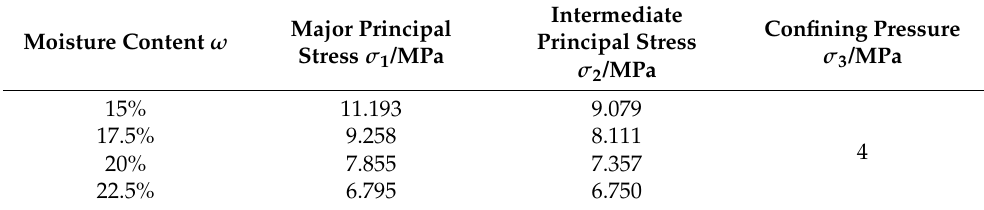
Table 8. Stress values corresponding to different water